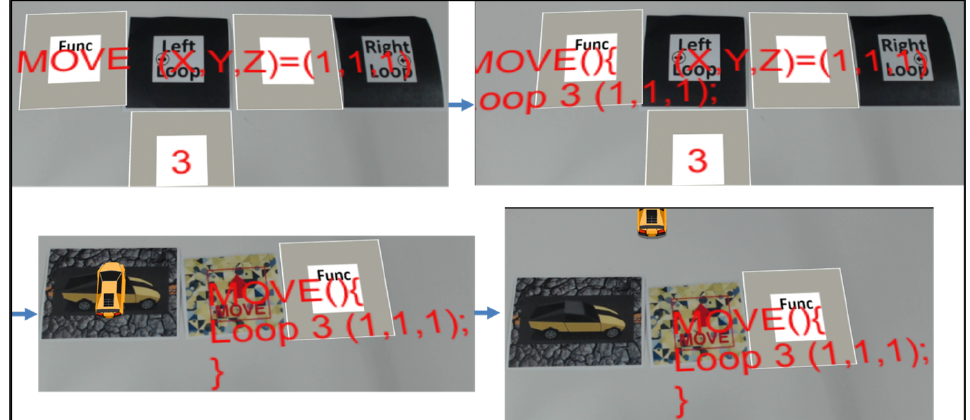
Figure 11. This is an example of controlling the 3D movement of the car. The markers will be read in a deep-first traversal mode—that is, read from left to right—and the column marker is read first when there is a column. The defined program is that the car moves with the 3D vector of (1, 1, 1) as a parameter and repeats this movement process 3